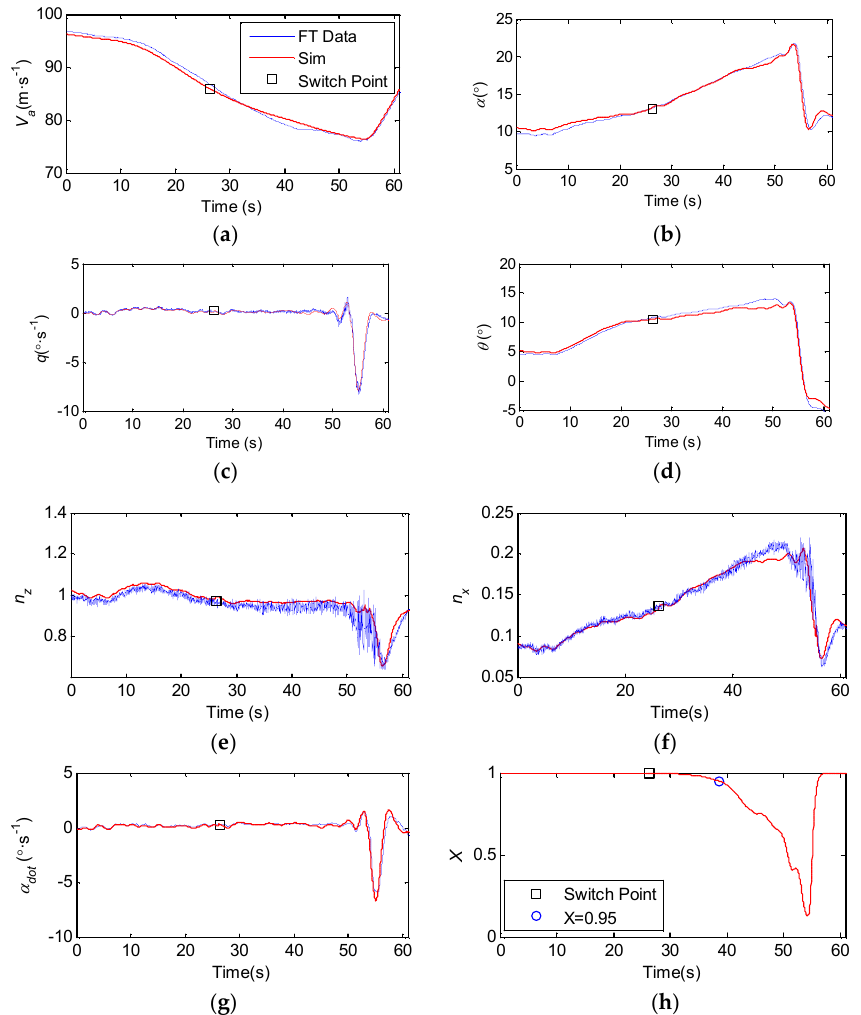
Figure 9. The comparison of response of motion model and flight test data. ( a ) Airspeed; ( b ) Angle of attack; ( c ) Pitch angular velocity; ( d ) Pitch angle; ( e ) z−axis overload; ( f ) x−axis overload; ( g ) Change rate of AOA; ( h ) Change of X .